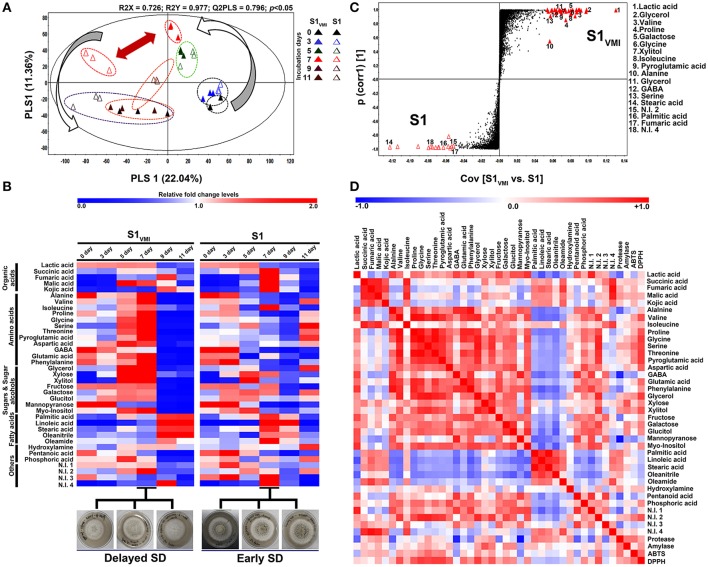
A time-correlated (A) PLS-DA score plot displaying the clustering patterns of metabolomic datasets, (B) heat map representation for the relative fold change levels of significantly discriminant metabolites (VIP > 0.7, p < 0.05), (C) S-plot for OPLS-DA analysis showing the discriminant metabolite biomarkers (VIP > 6, p < 0.05) for 7 days incubated samples, and (D) the heat map showing Pearson's correlation for linearity between detected metabolite patterns and associated biochemical phenotypes, derived from GC-TOF-MS detected primary metabolite datasets for A. oryzae RIB 40 (S1VMI and S1) sample extracts.